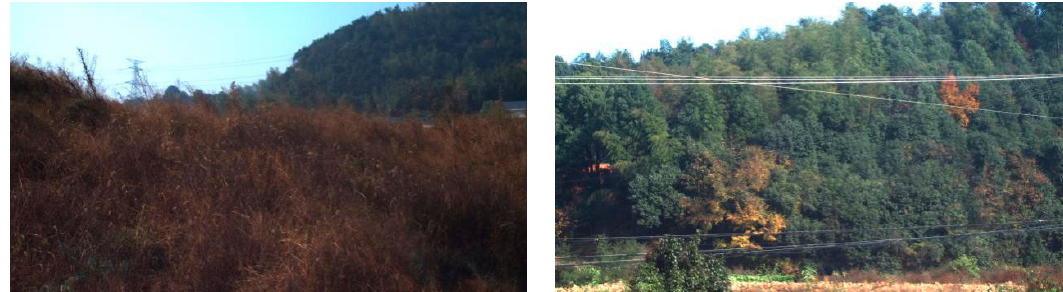
Figure 29. Examples of failing to locate when the skyline is too close to the camera.